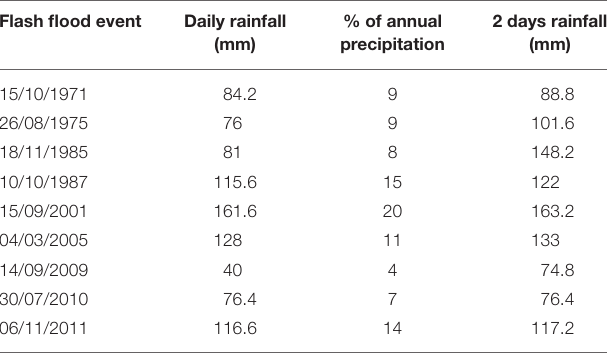
The“2-daysrainfall”columnreportstheoverallrainfallamountsmeasuredinboththeflash flood-related day and in the previous